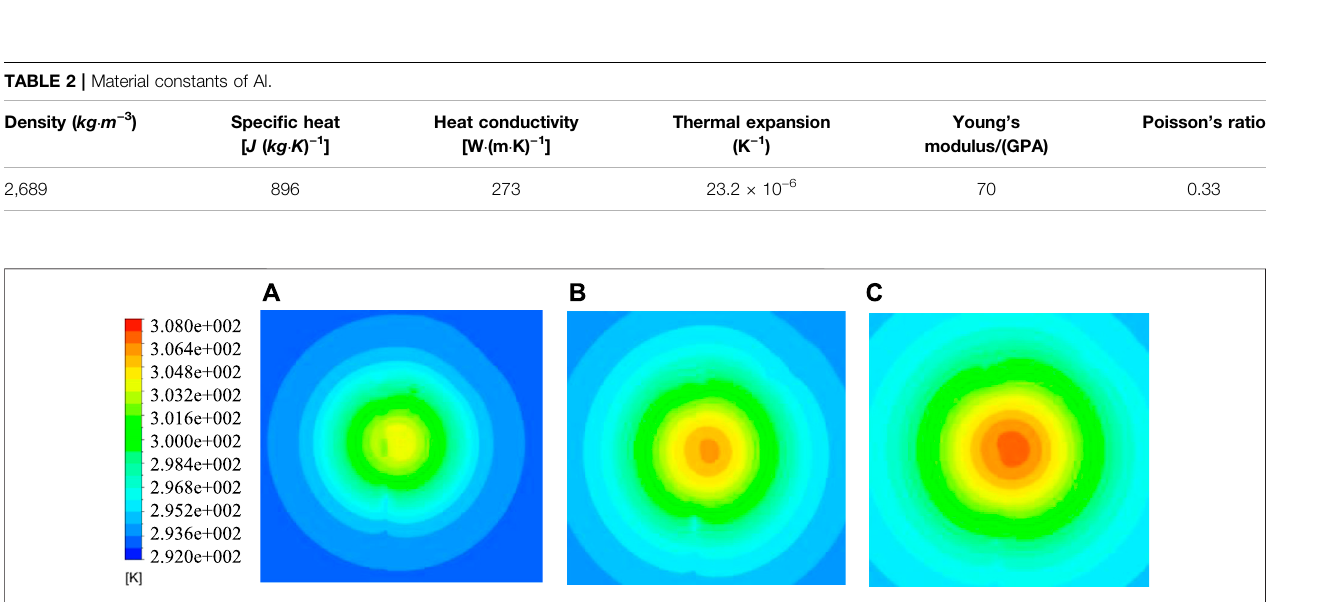
FIGURE 7 | The temperature distribution of grating surface at different irradiation times: (A) 10, (B) 30, and (C) 60 s.